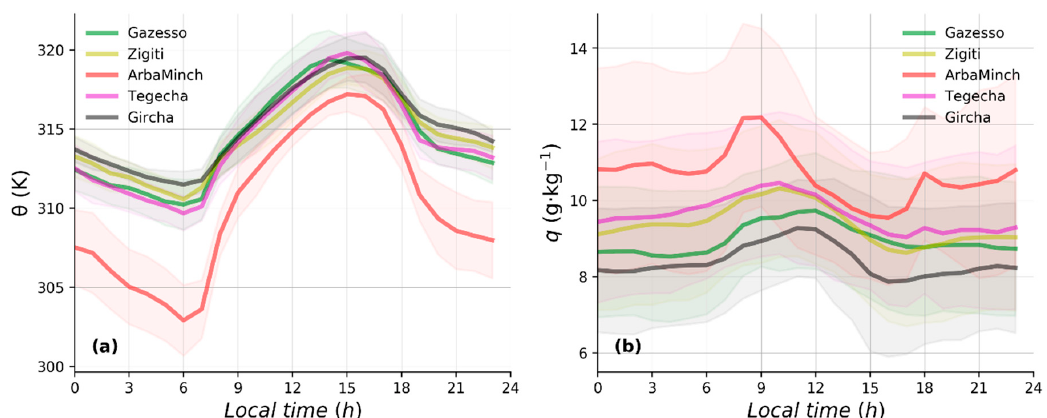
Figure 6. Diurnal evolution of potential temperature ( θ ) ( a ) and specific humidity (q) ( b ) in February 2017. The shaded regions show mean ± standard deviation (computed on hourly averages). Chencha is not included here for lacking SLP data (Table 2). Note that the standard deviation follows similar calculations to that of Figure 4.